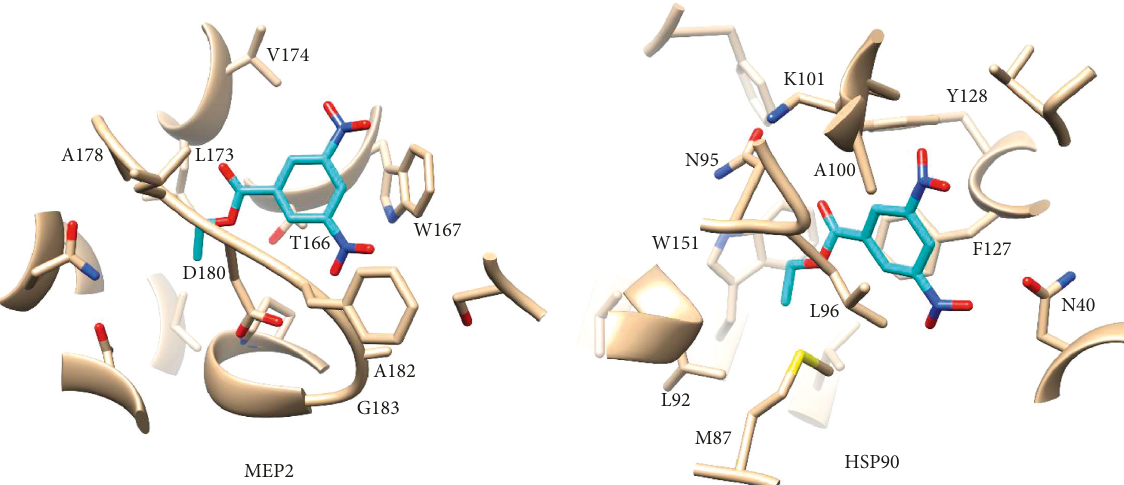
Figure 2: The predicted binding modes of compound 2 to the MEP2 (left) and HSP90 (right) targets. Receptors are depicted in gray and the ligand in cyan. The non-carbon atoms are colored as red for oxygen, blue for nitrogen, and yellow for sulfur. Only residues interacting with compound 2 in more than 50% of the analyzed MD snapshots are labelled in the